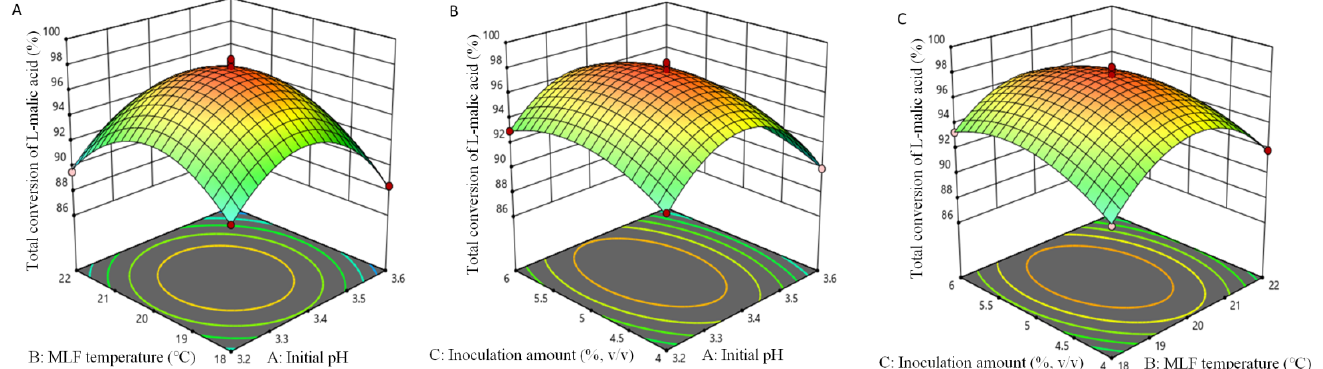
Figure 2. Response surface and contour plots for total conversion of L -malic acid in pear–kiwifruit wine as a function of the independent variables: ( A ) effect of the initial pH and malolactic fermen- tation temperature; ( B ) effect of the initial pH and inoculation amount; ( C ) effect of the malolactic fermentation temperature and inoculation amount.